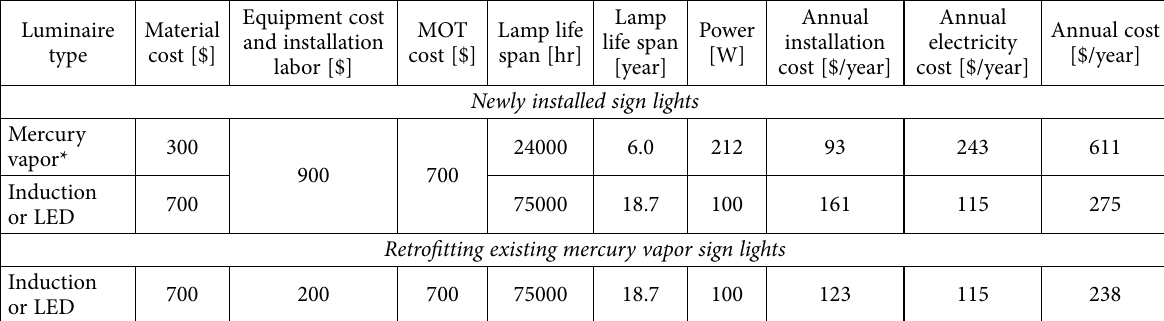
Table 7. Life-cycle costs of installation/retrofitting sign lights per guide